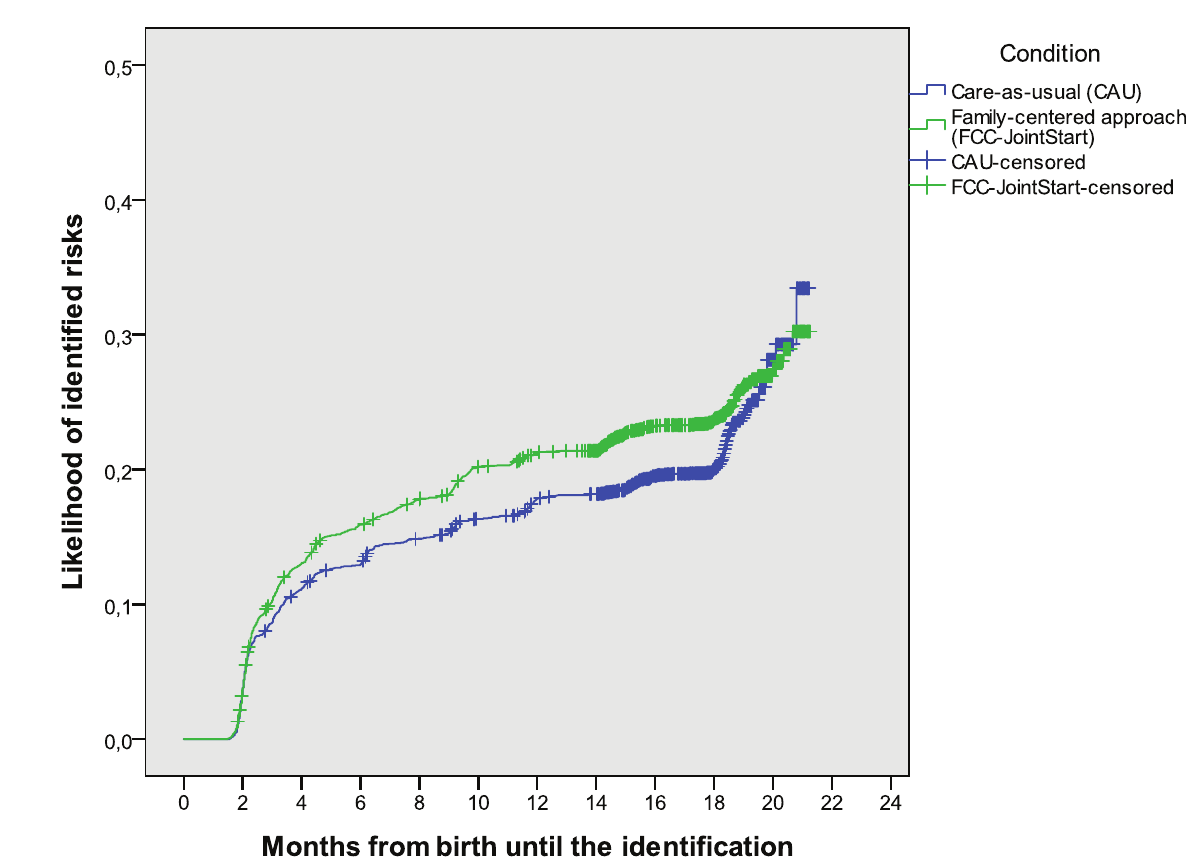
Fig 2. The likelihood of identification of (risks for) social-emotional problems over time, for children receiving family- centered care (FCC-JointStart) or Care-as-usual (CAU).